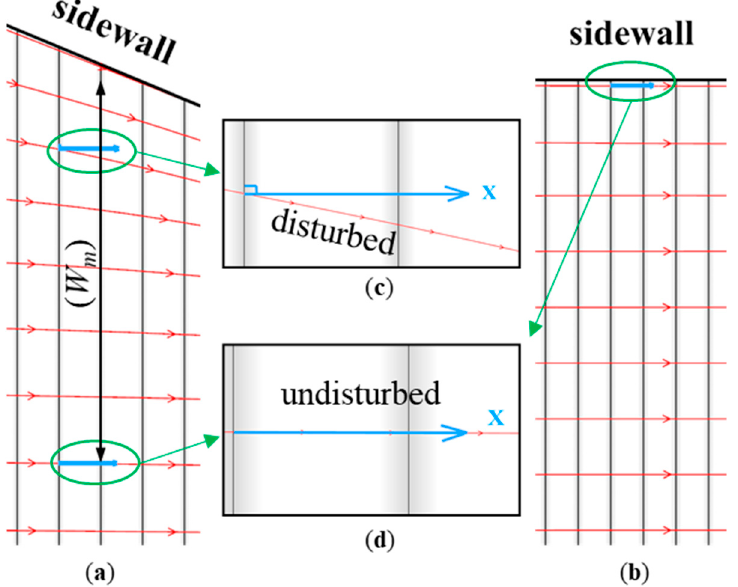
Figure 5. Streamlines of mainstream over: ( a ) converging stepped spillway; ( b ) uniform-width stepped spillway with θ = 48.3°, B = 22.5 mm, h c / B = 3.36 and Φ = 22.6°; ( c ) streamlines within disturbed region; ( d ) streamlines within undisturbed region.